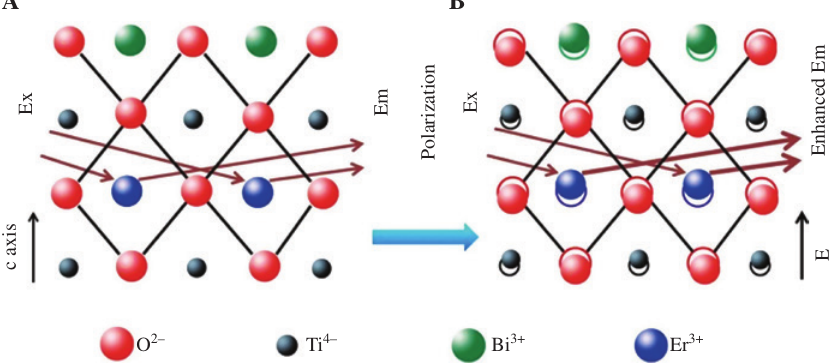
Figure 5: Schematic illustrations for changes of crystal structural characteristics before and after loading the electric field. (A) The bismuth layer structure diagram of Bi Bi Ti O is loaded after the electric field is 4 3 12